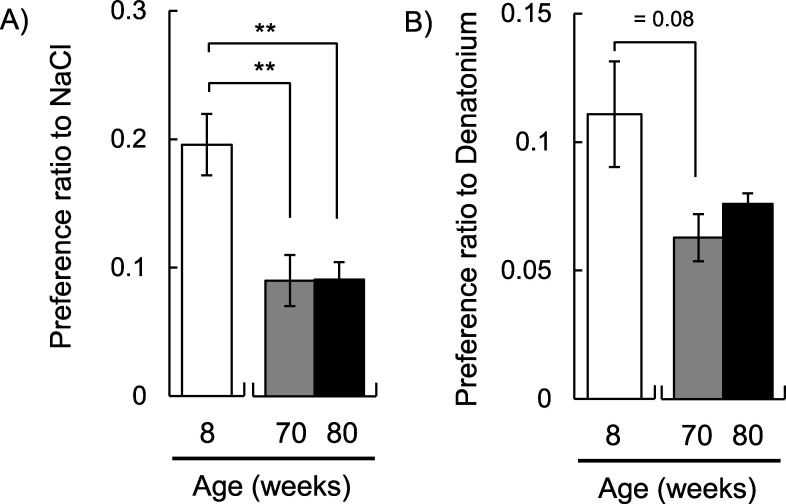
Taste sensitivity changes due to aging.The preference ratios for (A) salty (300 mM of NaCl) and (B) bitter taste (1 mM of denatonium) to water are shown (8-week-old mice for n = 24–25, 70-week-old mice for n = 19, 80-week-old mice for n = 13). The preference ratio to NaCl significantly decreased with age (F(2,54) = 8.34, p < 0.001; one-way ANOVA). The preference ratio to denatonium tended to decrease with age (F(2,53) = 2.65, p = 0.08; one-way ANOVA). ** p < 0.01 (Tukey posthoc test).